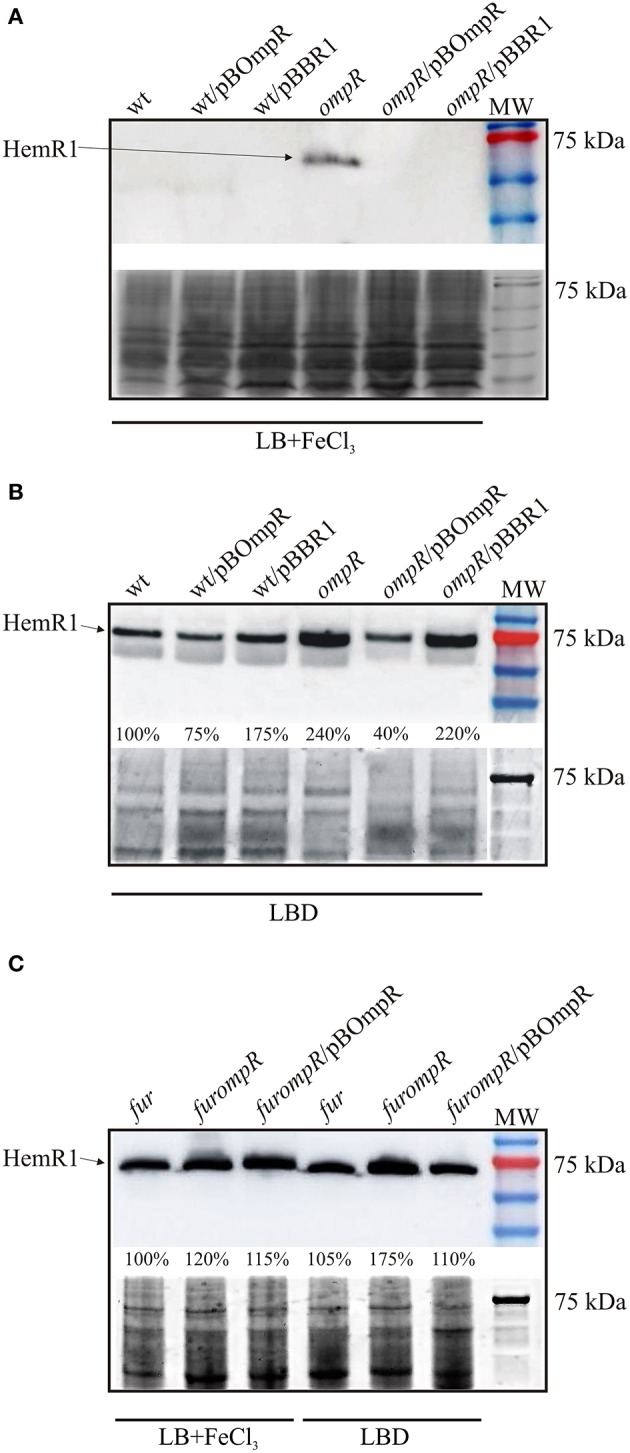
Effect of iron, Fur, and OmpR on HemR1 production. The level of HemR1 in cell extracts of strains grown overnight in LB+FeCl3 or LBD at 37°C analyzed by immunoblotting with a polyclonal HemR1 antibody. (A,B) The HemR1 level in the wild-type strain (wt), wt/pBBR1 (empty vector), wt/pBOmR (overexpression), the ompR mutant AR4, ompR/pBOmpR (complementation), and ompR/pBBR1 (empty vector) shown on Western blots (upper) with the stained gels as a loading control (bottom). (C) The HemR1 level in the fur mutant background, i.e., fur mutant, furompR double mutant, and furompR/pBOmpR. The percentage values indicating the HemR1 band intensities in the tested strains relative to the wt (B) and fur mutant (C), were determined using Amersham Imager 600 Analysis Software V1.0.0 (GE Healthcare). Stained gels shown as a loading control: (A,C) TGX Stain-Free gels (BioRad), (B) Coomassie blue stained gel. MW, 3-Color Prestained Protein Marker, kDa. The size of the HemR1 band is approximately 75 kDa on the Western blots. This result is representative of at least three independent experiments.